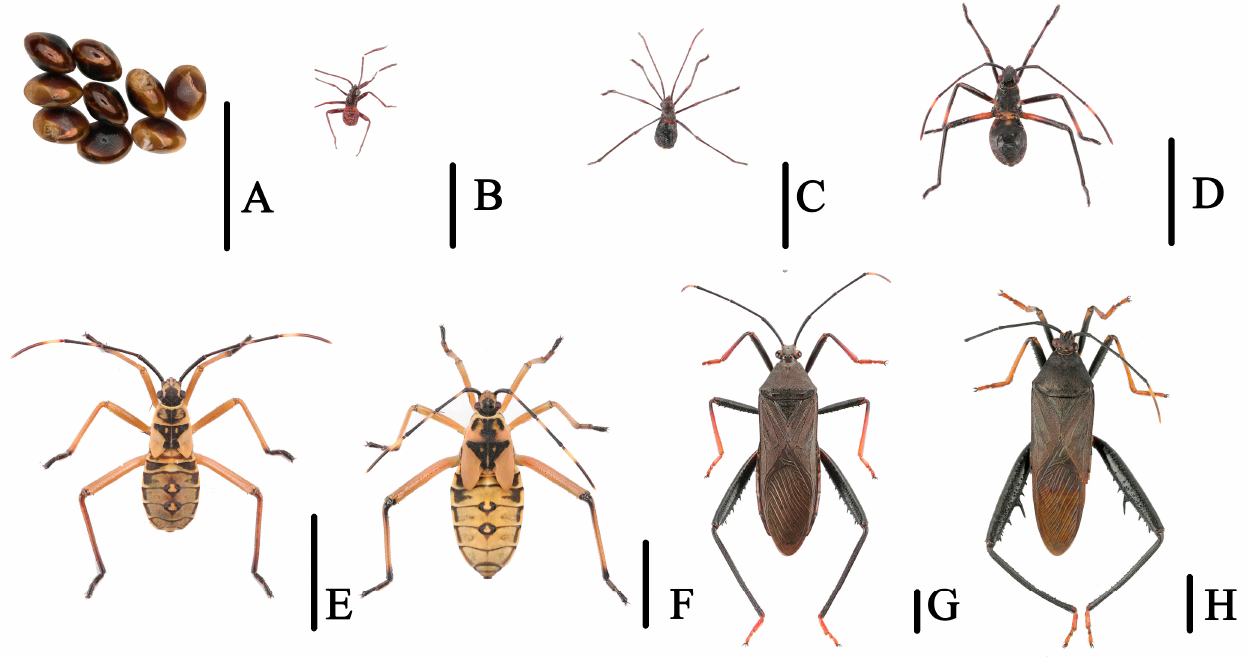
Figure 2. The complete life stages of Notobitus meleagris (Fabricius) from eggs to adults. ( A ). Egg mass; ( B – F ) First to fifth nymphal instars; ( G ) Adult, female; ( H ) Adult, male. Scale bars = ( A – H ) (5000 µm).